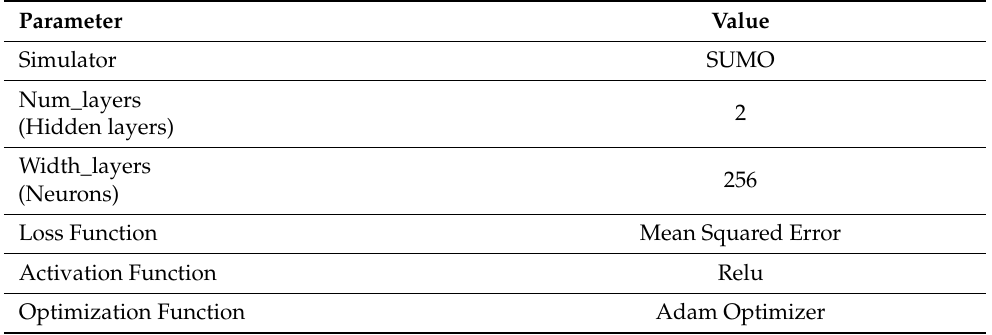
Table 4. Structure of neural network.